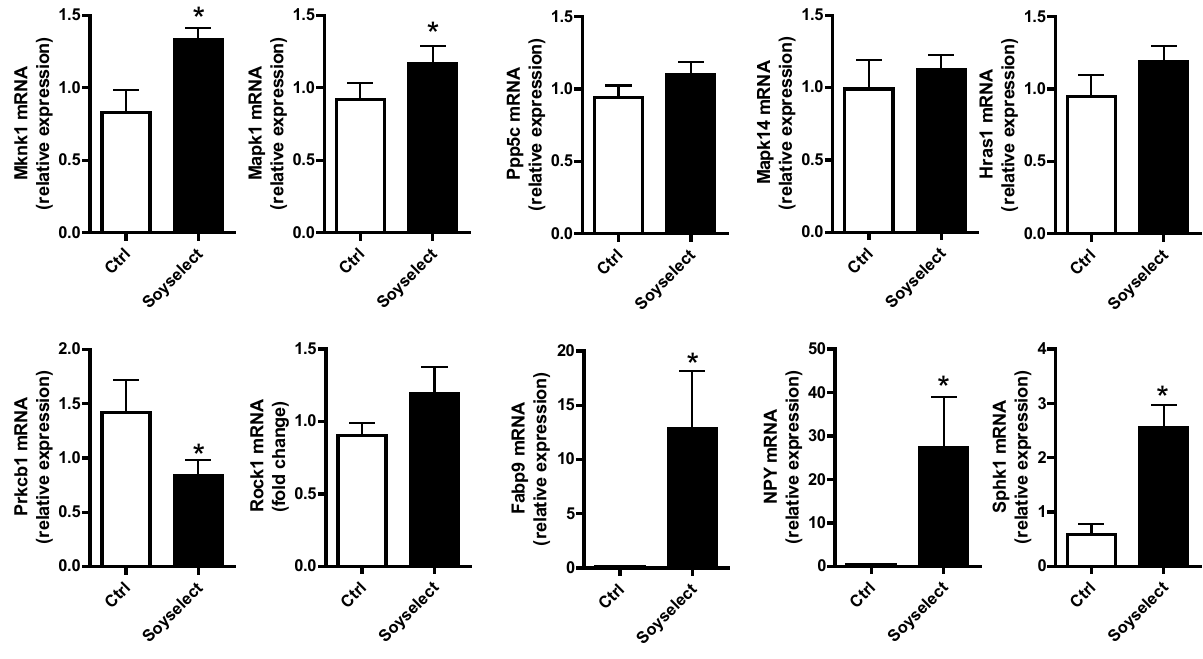
Figure 3. RT- qPCR validation of selected genes related to MAPK, TGFβ, chemokine signaling, and others related to lipid metabolism. Mice received either chow diet (ctrl) or 0.45% Soyselect ® during eight weeks. mRNA is given as relative expression ( n = 6 per group). * p < 0.05 as compared with